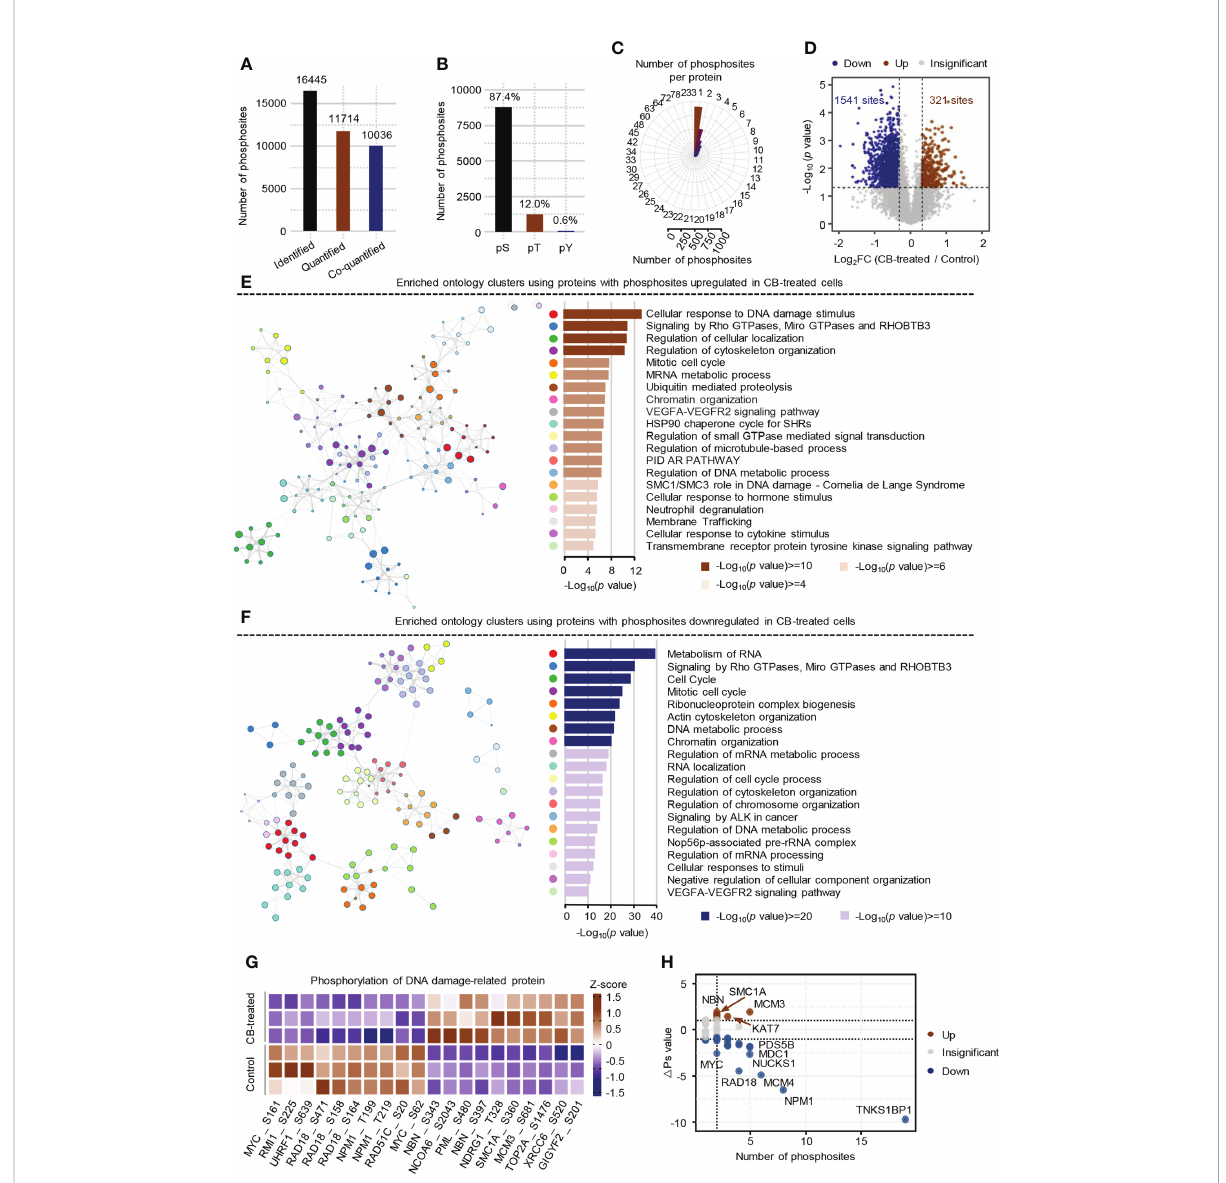
FIGURE 3 Phosphoproteome pro fi le of CB-treated RBE cells. (A) The statistics of identi fi ed and quanti fi ed phosphosites. Co-quanti fi ed means both phosphosites and the corresponding proteins were quanti fi ed. (B) The percentages of phosphosites on serine, threonine and tyrosine residues. (C) The statistics of the number of phosphosites on each protein. (D) Volcano Plot of signi fi cantly altered phosphosites ( p < 0.05 (Student ’ s t -test) and ratio (CB/Ctr) > 1.25 or < 0.8). Brown represents up-regulated, blue means down-regulated. (E, F) Pathway enrichment analysis of proteins with up- regulated (E) and down-regulated (F) phosphosites using Metascape. The colors of the dots in the network represents different biological pathways. (G) Heatmap of the top 10 DNA damage-related phosphosites that were signi fi cantly changed in CB-treated versus untreated cells. (H) Global D Ps analysis of phosphoproteins involved in DNA damage. Brown represents up-regulated, blue means